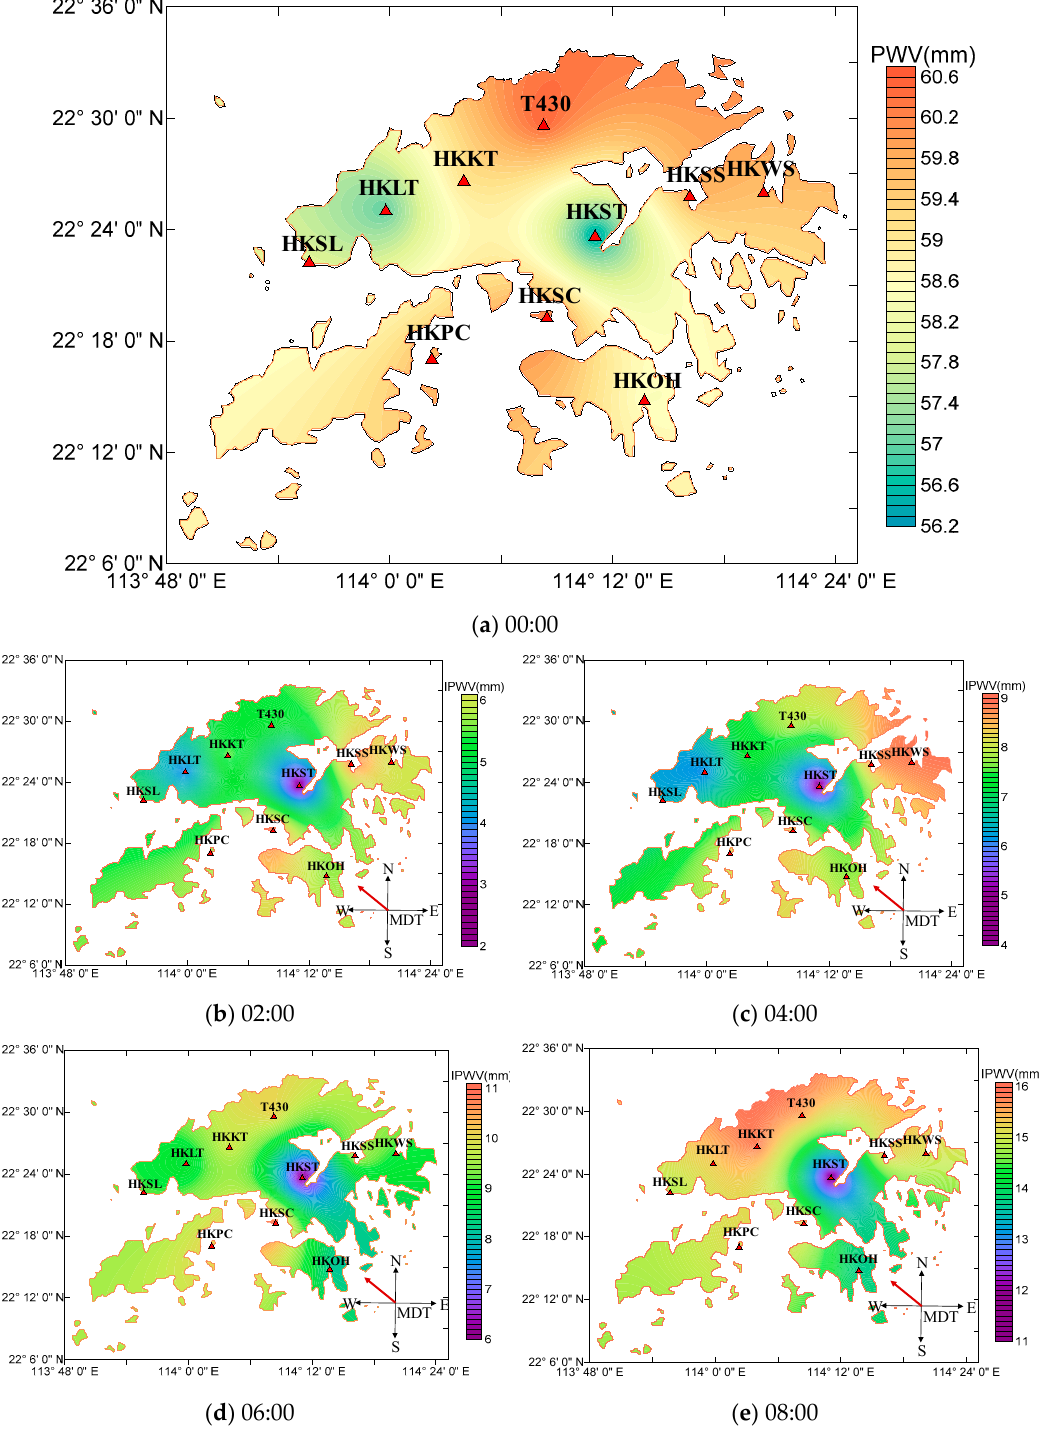
Figure 14. ( a ) Snapshots of Hong Kong regional PWV at 00:00 on the 16th; ( b – e ) Snapshots of increment of PWV (IPWV) maps in the region every 2 h from 02:00 to 08:00 on the day, where the red arrow denotes the moving direction of the typhoon (MDT) roughly.